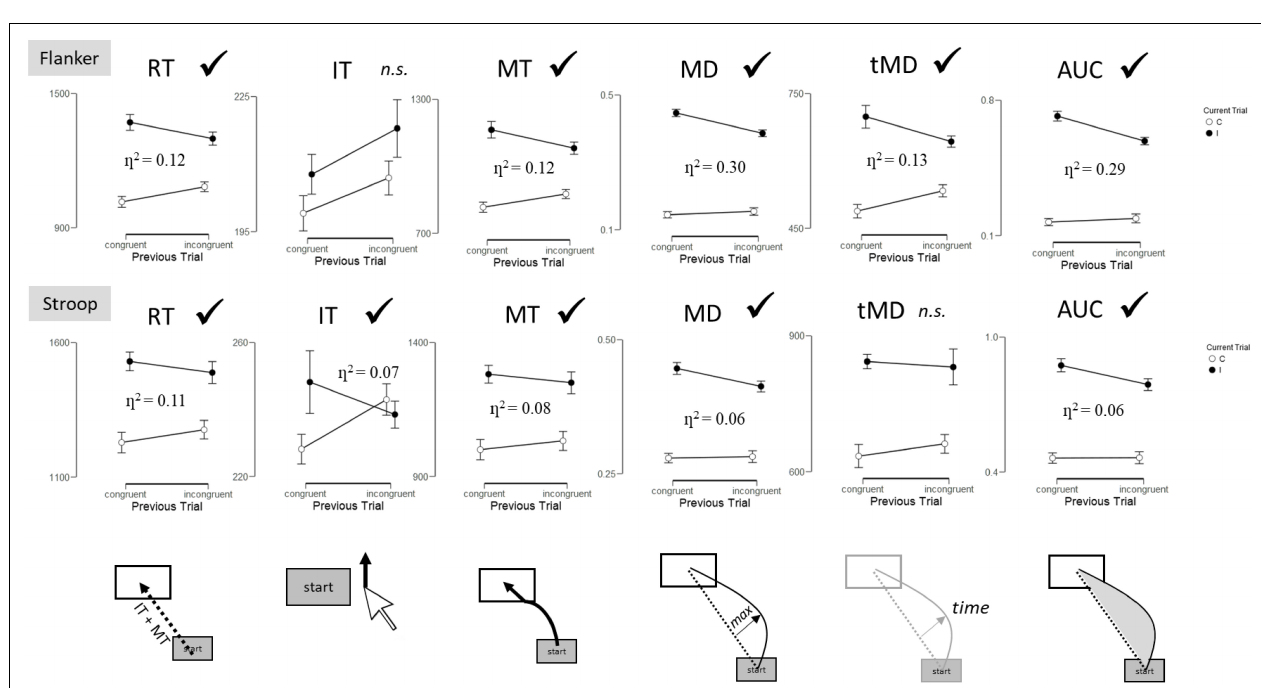
FIGURE 2 | Example trial and dependent variables recorded (to the right) for the Flanker task in the present experiment. The dotted lines represent the contour of the computer screen. The Stroop task was similar but participants responded to the ink of colored words rather than arrows and the response options were RED/GREEN and ORANGE/BLUE rather than LEFT and RIGHT.